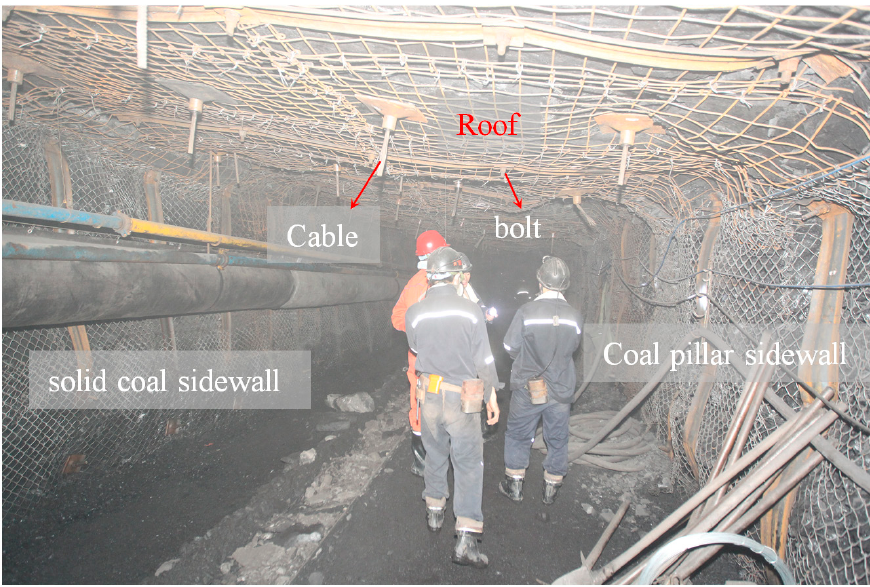
Figure 12. Photos of zone A in MTR 1513.